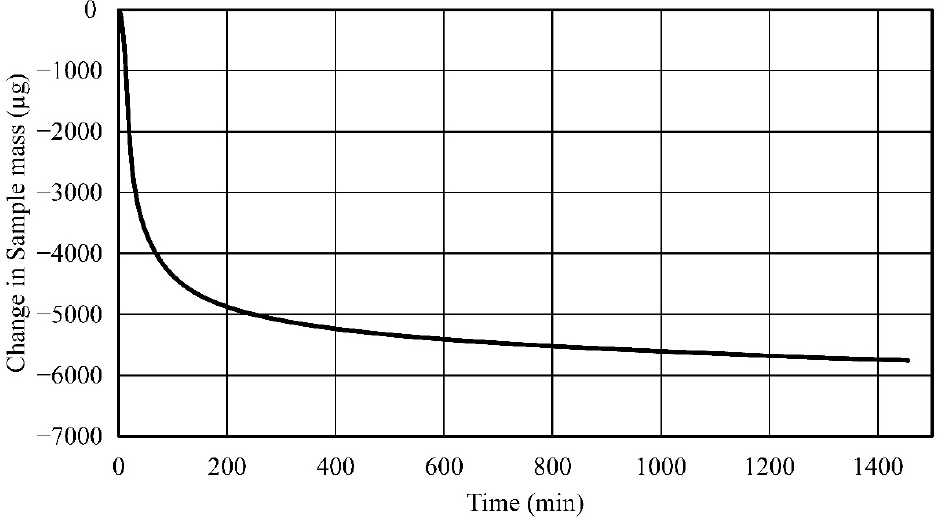
Figure 5. Effect of carbonation duration and post-UV exposure time on polymer weight.